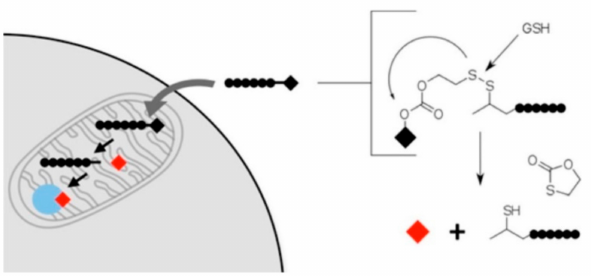
Figure 7. Linker mediated mitochondrial transport